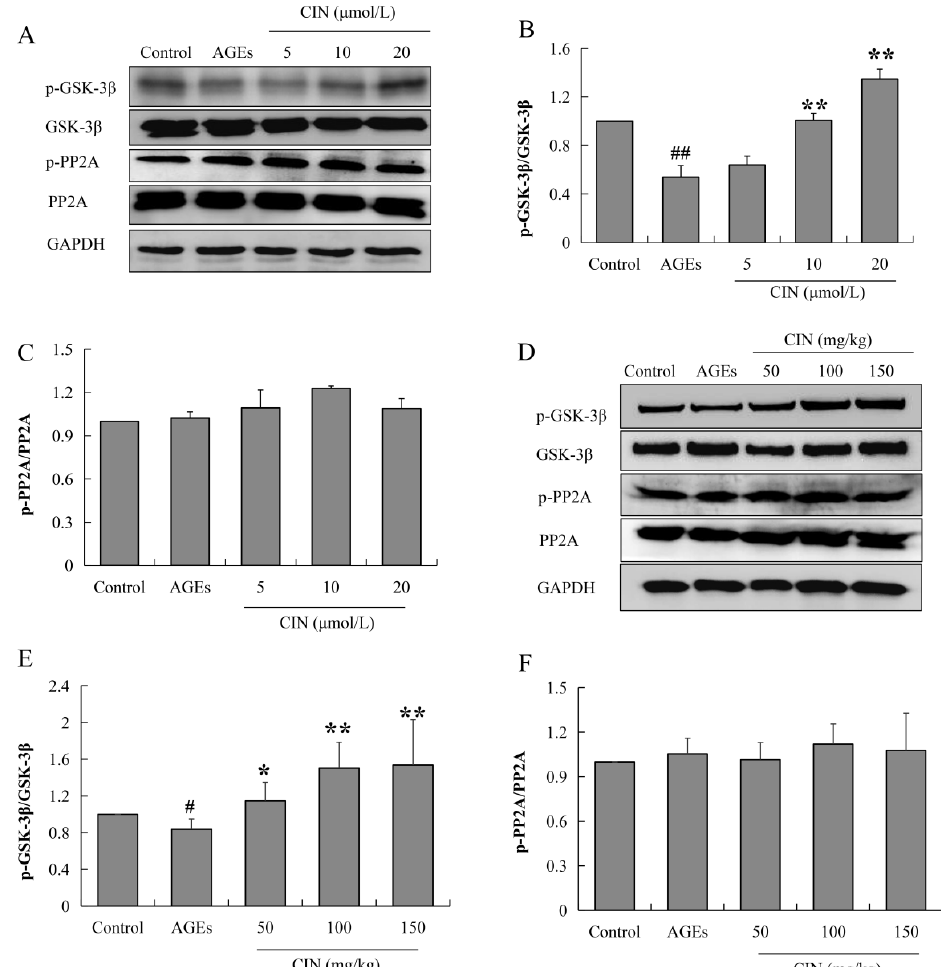
Figure 5. Effects of CIN on the activities of GSK-3 β and PP2A in vitro and in vivo. ( A – C ) The protein levels of GSK-3 β and PP2A in SH-SY5Y cells were detected by Western blot. n = 3. ( D – F ) The protein levels of GSK-3 β and PP2A in rat hippocampus were detected by Western blot. n = 8. # p < 0.05, ## p < 0.01 compared with the control group; * p < 0.05, ** p < 0.01 compared with the model group.